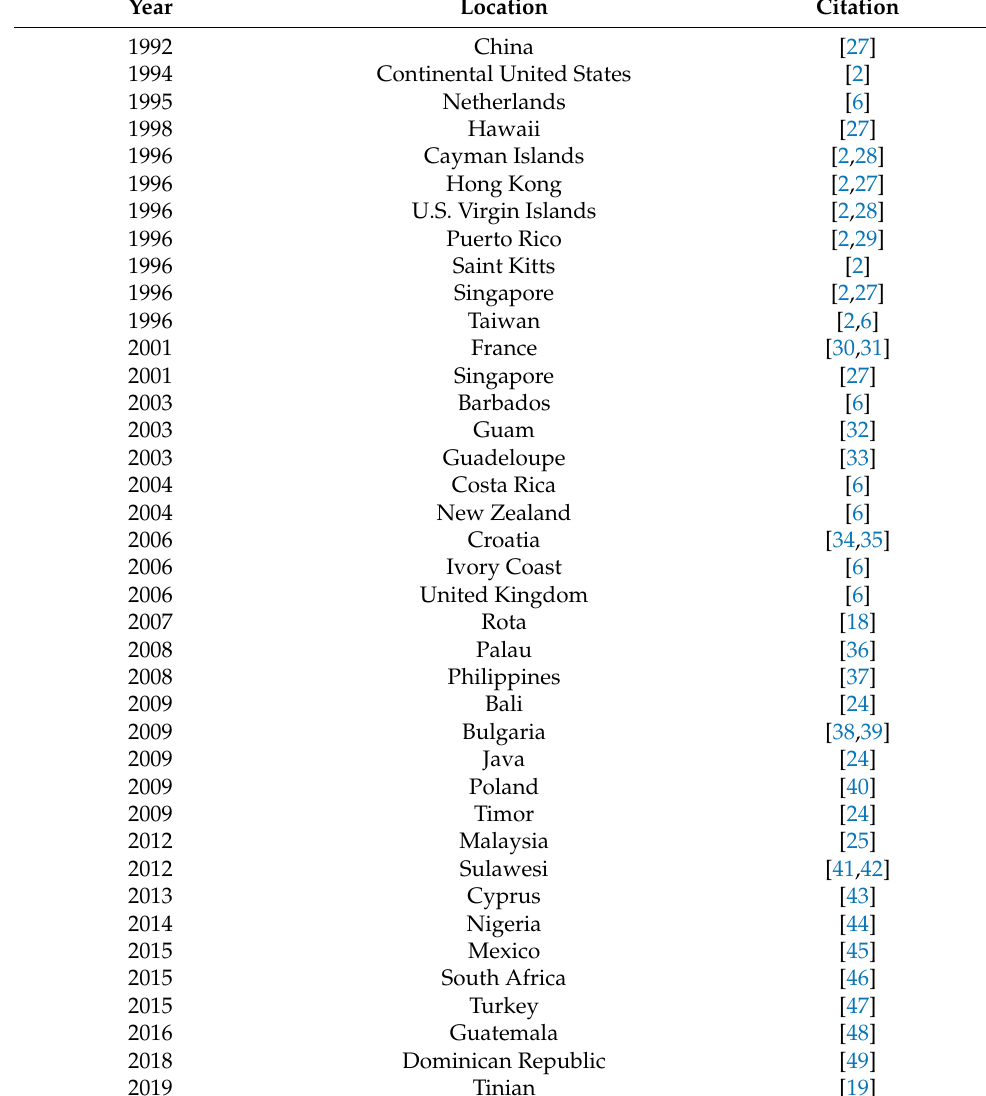
Table 1. List of geographic locations which have reported Aulacaspis yasumatsui on established cycad plants or on plants intercepted at a port of entry. The list does not include countries within the unambiguous native range of the